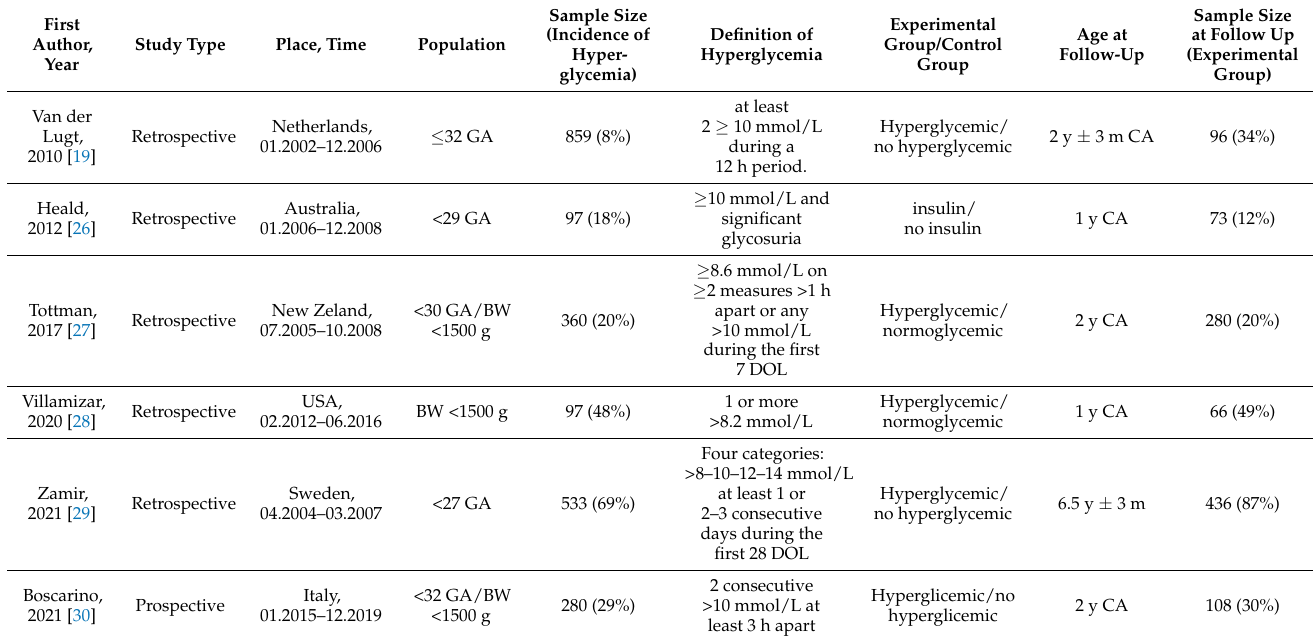
Table 1. Details of included